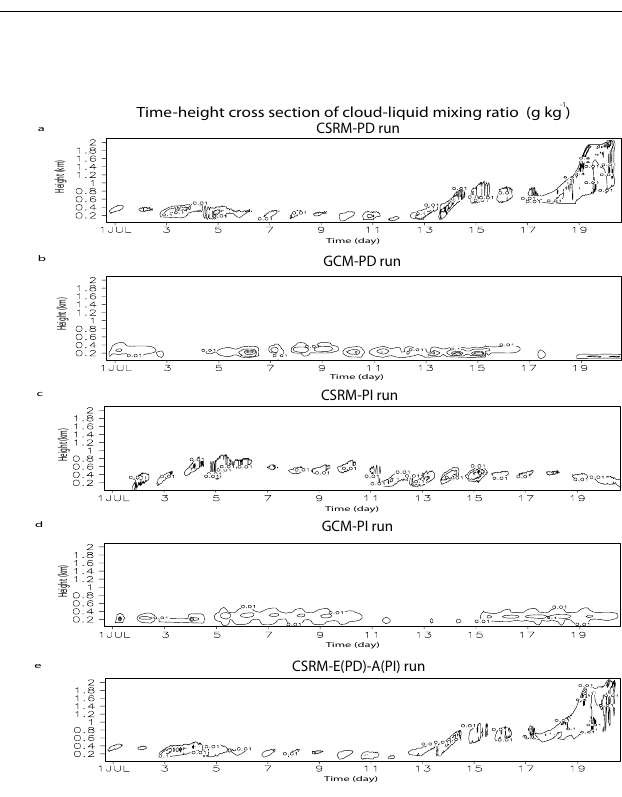
Fig. 6. Time-height cross section of cloud-liquid mixing ratio (g kg − 1 ) for (a) the CSRM-PD run, (b) the GCM-PD run, (c) the CSRM-PI run, (d) the GCM-PI run, (e) the CSRM-E(PD)-A(PI) run. Contours are at 0.01, 0.1, 0.4, and 0.6gkg − 1 for the period be- fore 00:00LST on 17 July in the CSRM-PD run and for the entire period in the GCM-PD and -PI runs and the CSRM-PI run. For the period after 00:00LST on 17 July in the CSRM-PD run, contours are at 0.01, 0.4, and 0.6gkg − 1